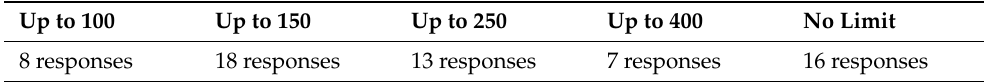
Table 12. Participants’ responses concerning the number of words for the abstracts.